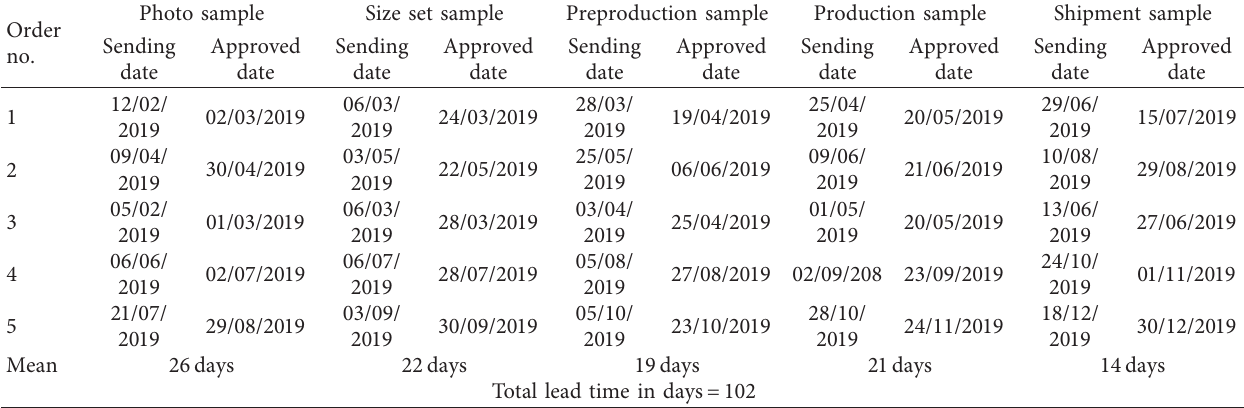
Table 1: Company A, date-wise sample approval data taken from five different orders.